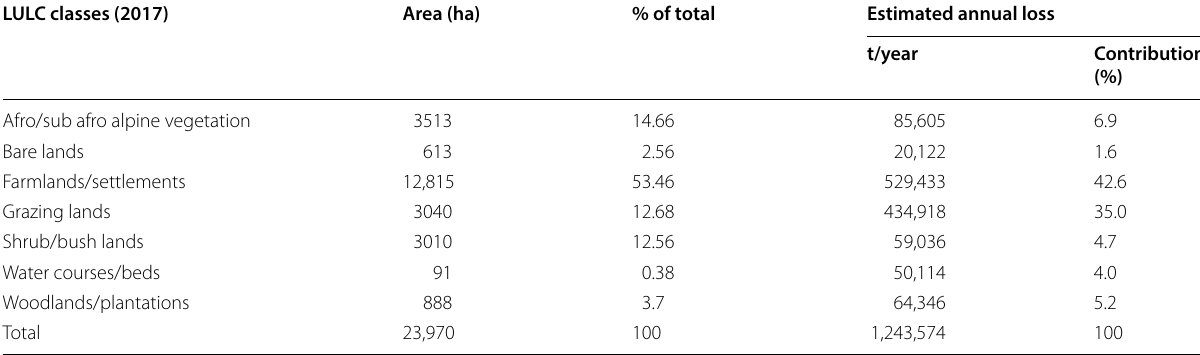
Table 9 Soil erosion by LULC